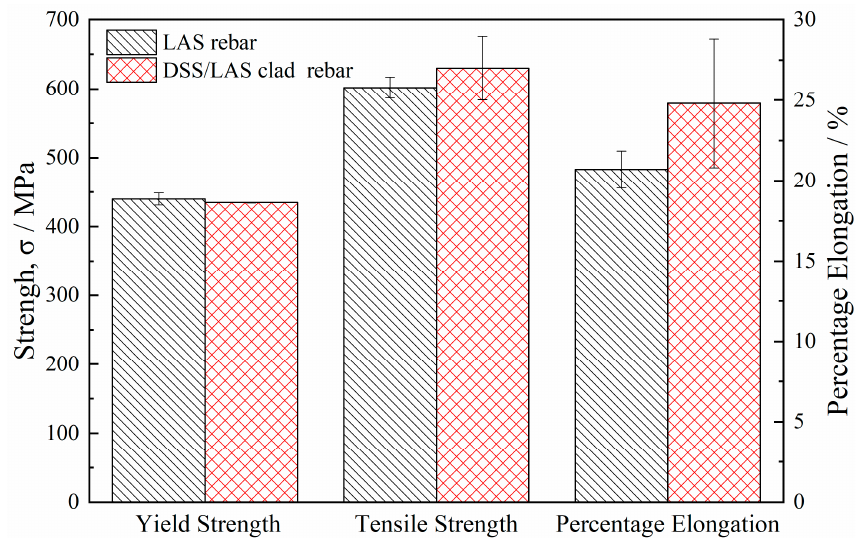
Figure 8. Tensile properties of the LAS rebar and the DSS/LAS-clad rebar.